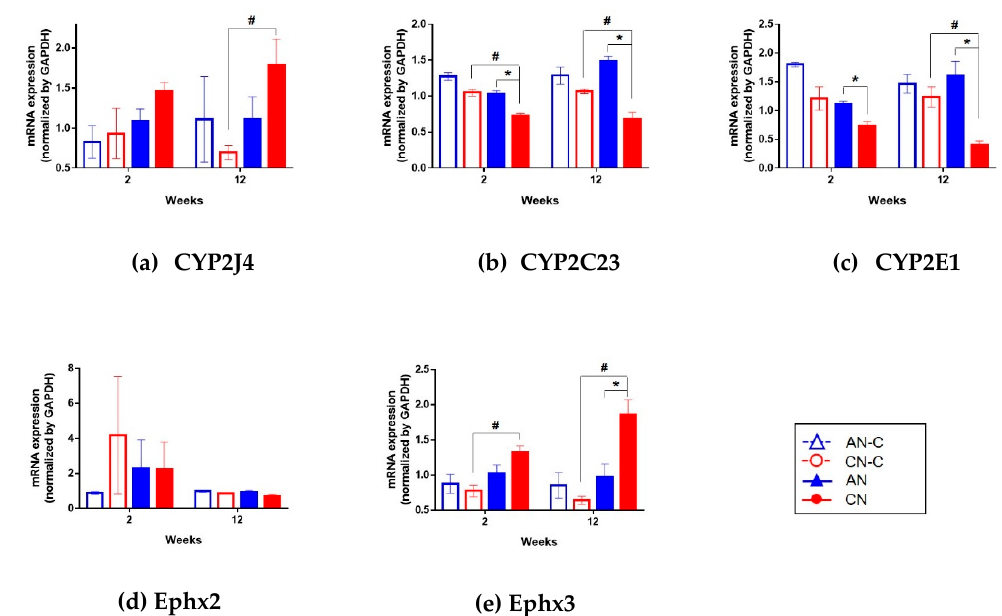
Figure 7. Renal mRNA expression of ( a ) CYP2J4 , ( b ) CYP2C23 , ( c ) CYP2E1 , ( d ) Ephx2 , and ( e ) Ephx3 at the Week 2 and 12 time points. CYP2C23 and CYP2E1 were lower in the CN group than in AN or CN-C animals. Ephx3 expression was higher with CN than in AN or CN-C groups. The Mann–Whitney